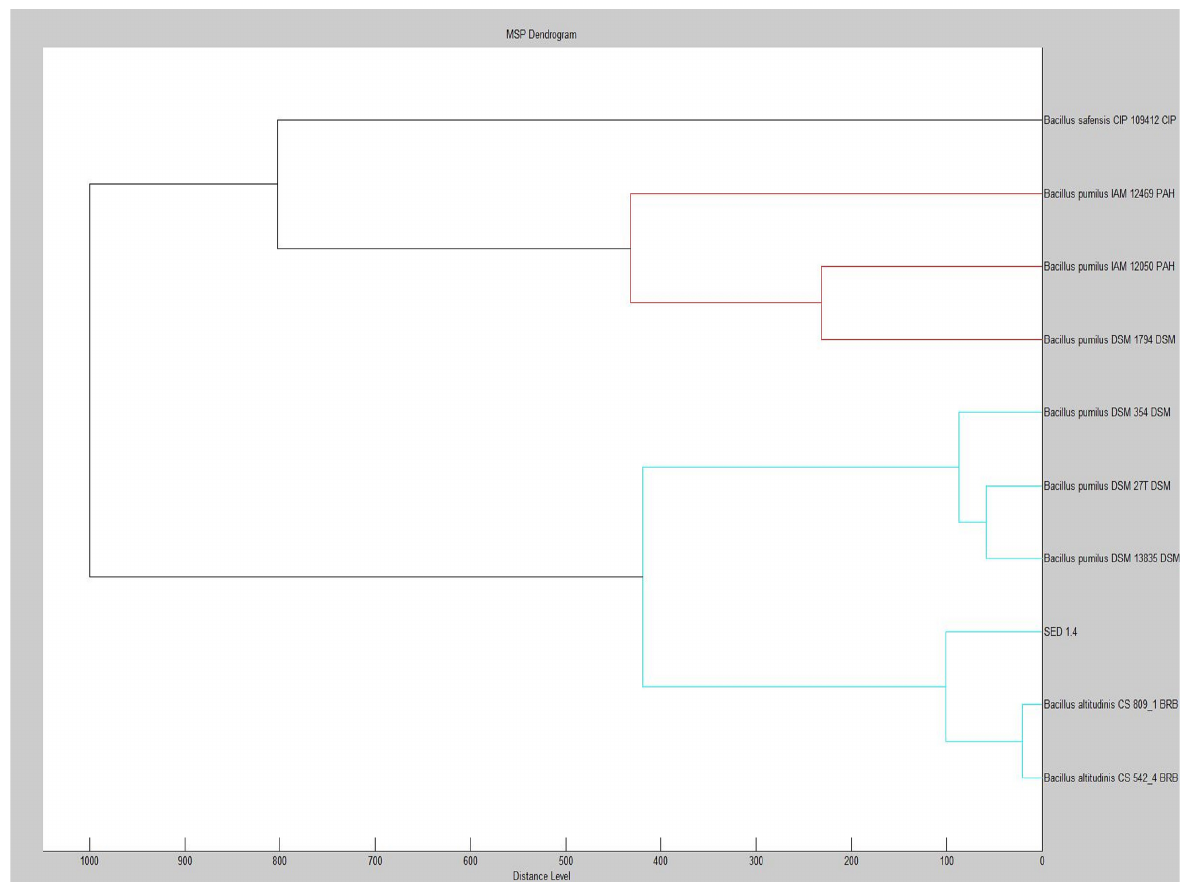
Figure 1. Dendrogram of Bacillus species showing the levels of similarity in the phenotypic expression of proteins present in the isolates.